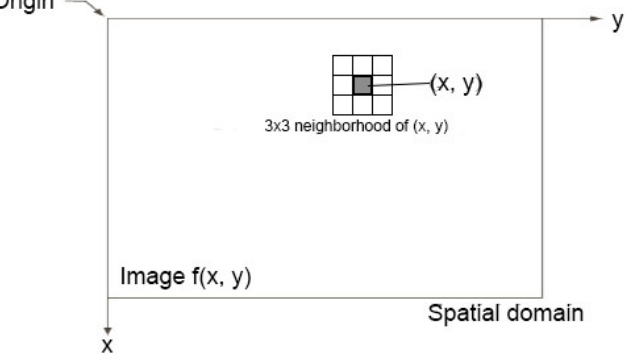
Figure 8. 3 × 3 neighborhood about a point in an image.